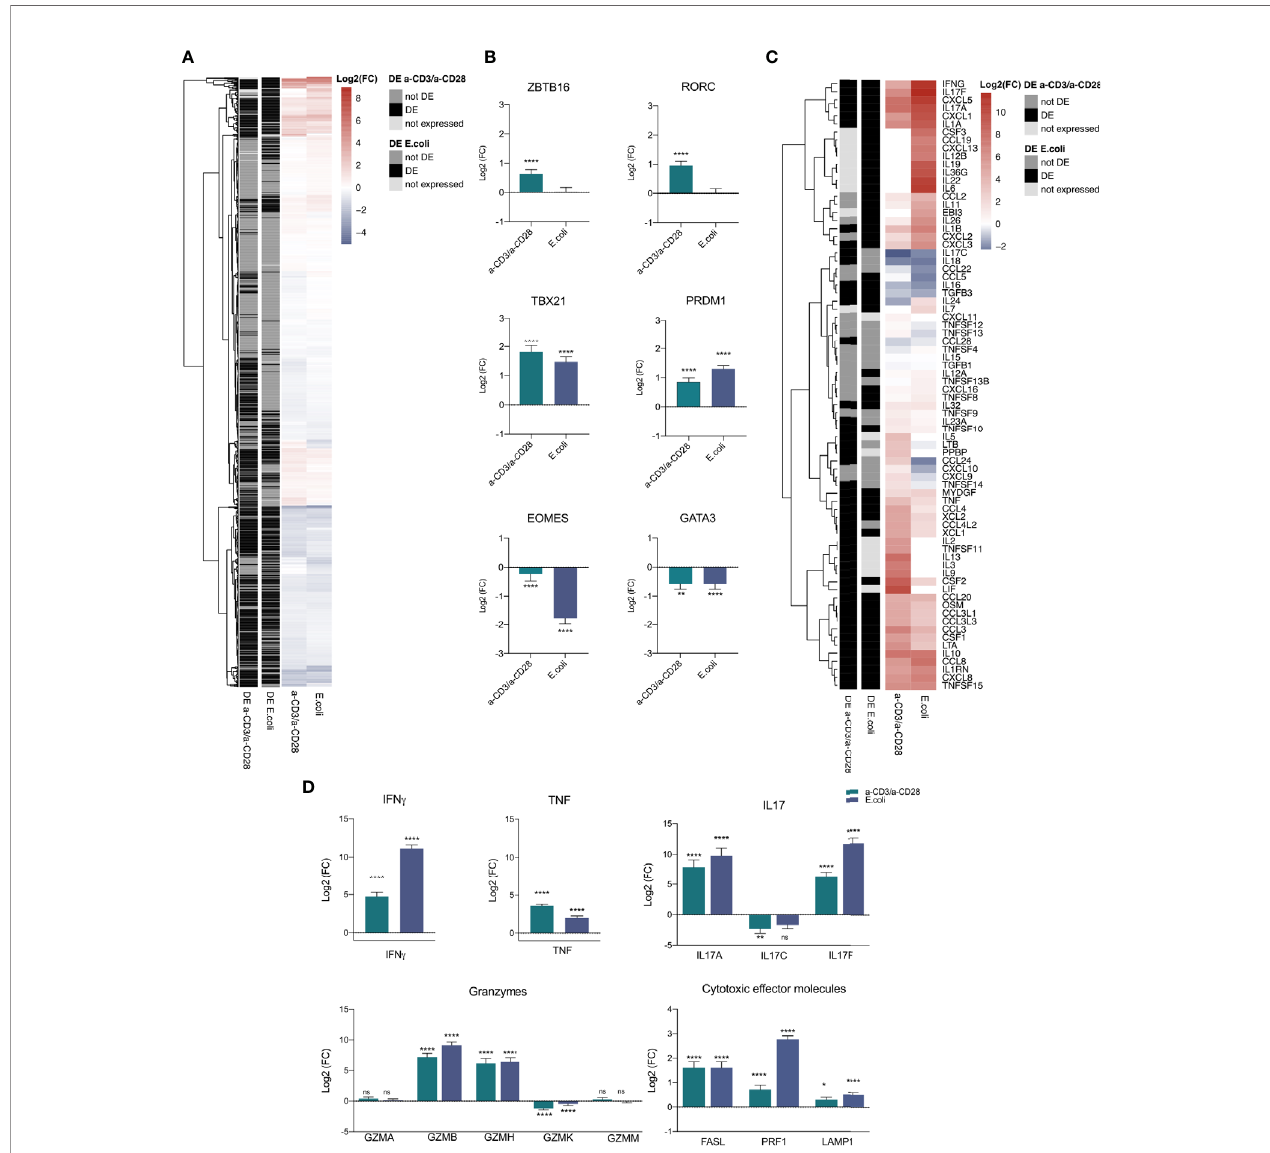
FIGURE 3 | Transcription factor and cytokine mRNA pro fi le of activated MAIT cells. (A) Heatmap of 1115 expressed transcription factors in the transcriptome of a-CD3/a-CD28 or E.coli -activated MAIT cells. (B) Log2(FC) mRNA expression of selected transcription factors (mean +SD, n = 5). Levels of signi fi cance are given as FDR-adjusted p-values with **** ≤ 0.0001,*** ≤ 0.001, ** ≤ 0.01 and * ≤ 0.05. (C) Heatmap of 75 expressed cytokines and chemokines in the transcriptome of a-CD3/a- CD28 or E.coli -activated MAIT cells. (D) Log2(FC) mRNA expression of selected cytokines and cytotoxic molecules in activated MAIT cells (mean +SD, n = 5). Levels of signi fi cance are given as p.adj with **** ≤ 0.0001, *** ≤ 0.001, ** ≤ 0.01 and * ≤ 0.05; n.s., not signi fi